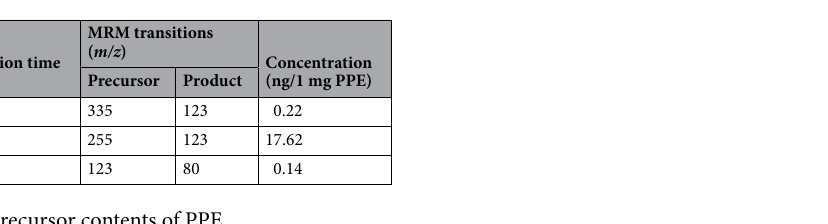
Figure 3. The active fraction of LMW-PPE contains several NAD precursors. ( A ) LMW-PPE (1 mg) was separated and monitored at the multiple-wavelength (200–600 nm) using HPLC. ( B ) The eluents were collected per 2 min and tested for NAD recovery activity in each fraction. ( C ) The fraction 3 was analyzed using LC–MS/ MS. All compounds were detected in positive ion mode.